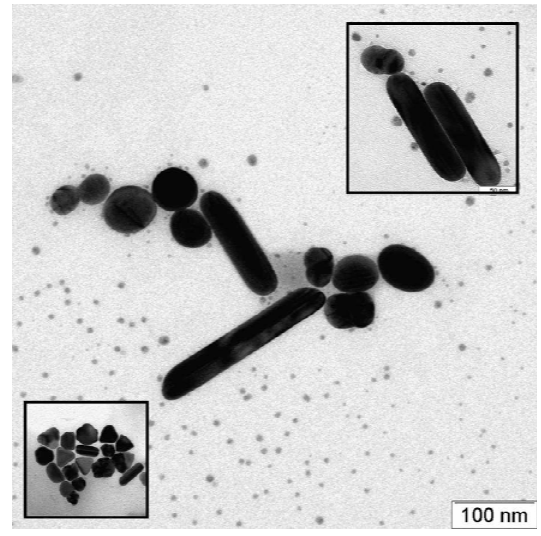
Figure 3. TEM micrograph of silver nanorods suspension after three min of